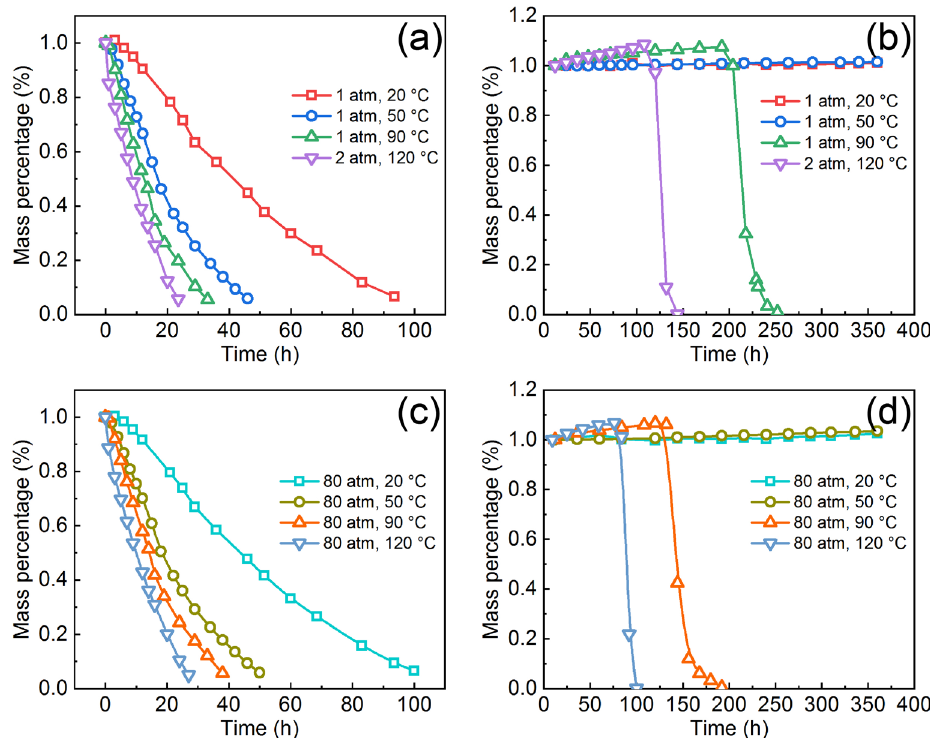
Figure 8. Weight loss-time curves for the bare Mg-RE alloy and the coated Mg-RE alloy in 3 wt.% KCl solution: ( a , b ) at normal pressure, ( c , d ) at high pressure. KCl solution: ( a , b ) at normal pressure, ( c , d ) at high